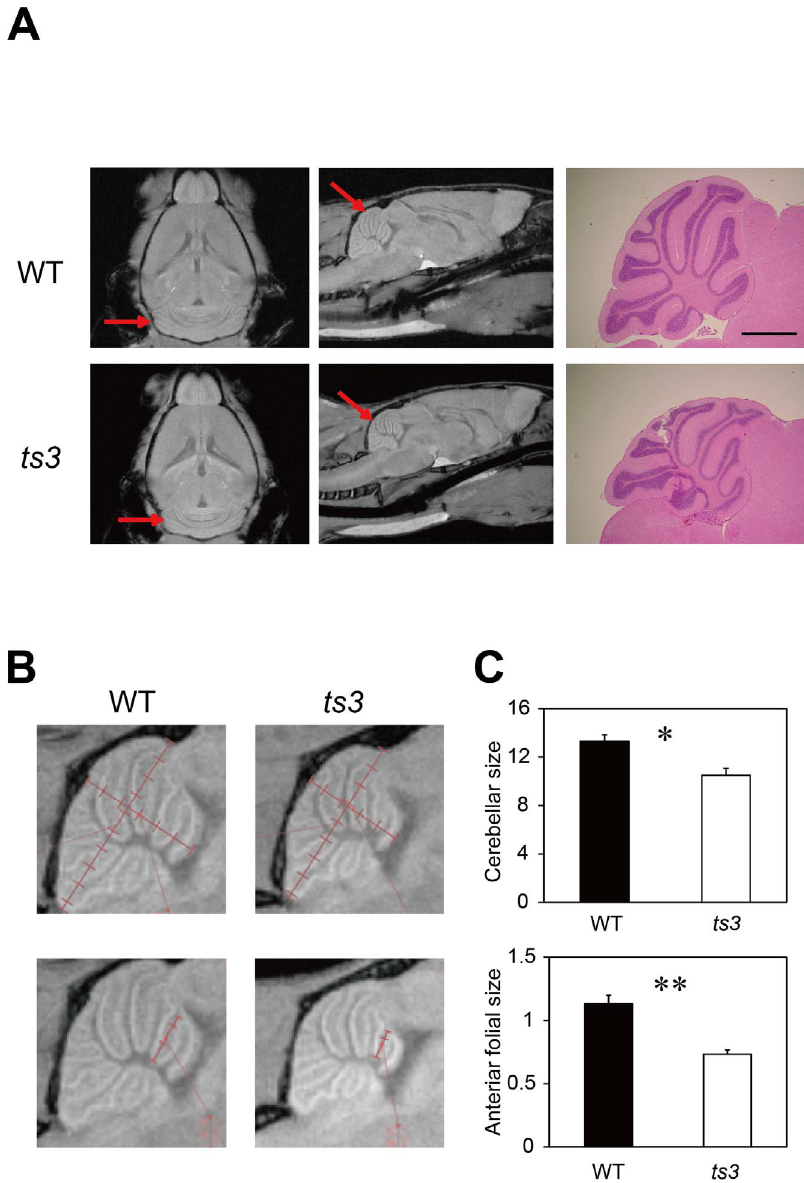
Figure 2. Cerebellar atrophy in the ts3 mutant mice revealed by Micro-MRI and histological analysis. A) Brain images acquired by micro- MRI (left and middle panels). Horizontal (left) and sagittal (middle) images of cerebella indicate cerebellar atrophy in the ts3 mutant (lower panels) and WT control (upper panels). The right panels show H&E-stained cerebellar sagittal sections of the ts3 mutant (lower) and WT control (upper). Scale bar indicates 1 mm. B, C) Cerebellar size of ts3 mutants and WT controls. First, the lengths of major and minor axes (mm) of the whole cerebellum were measured by micro-MRI (B, upper panels). They were consequently multiplied and compared between two genotypes (C, upper, n=6, unit: mm 2 ). To examine significant anterior folial atrophy in ts3 cerebella, we also measured the length of the folia (shown in B, lower) and compared in ts3 and WT mice (C, lower, n=6, unit: mm). * P , 0.05, ** P , 0.01.